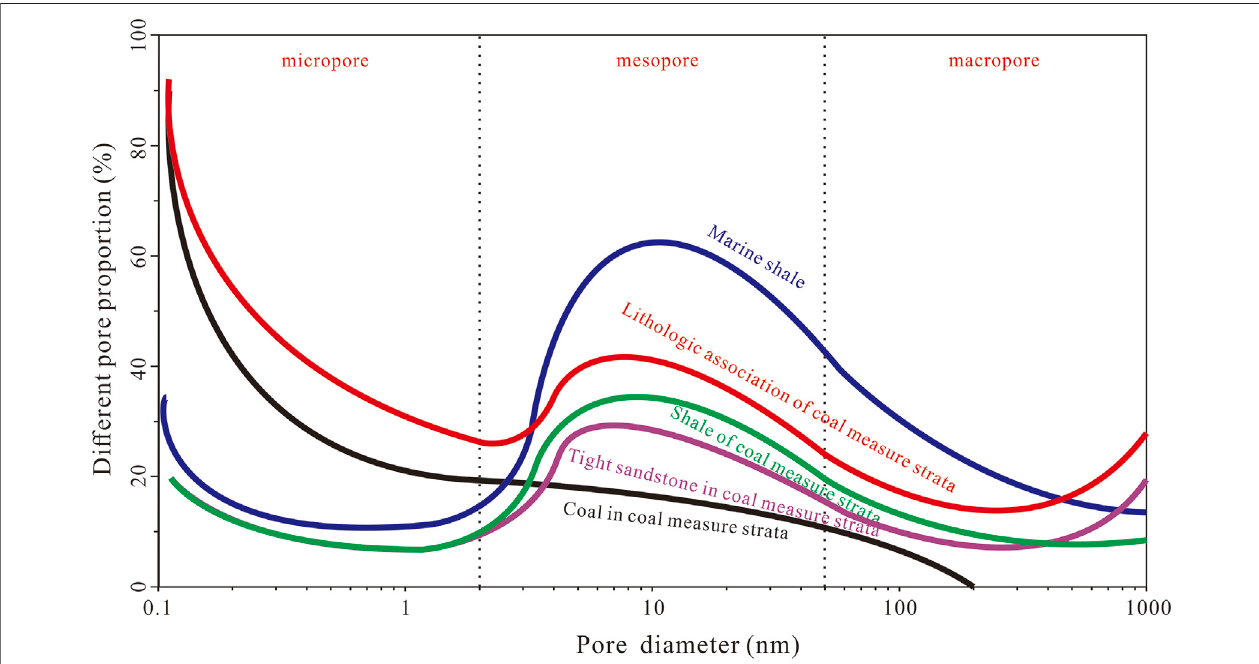
FIGURE 14 | Proportion of pores of different scales in different types of coal measure reservoirs.